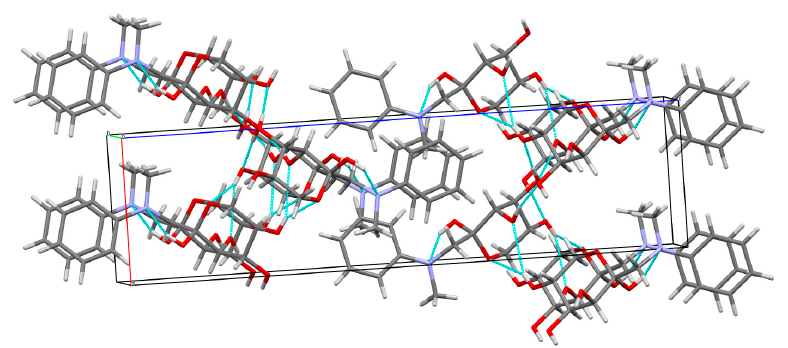
Figure 3. Crystal packing of N -(1-deoxy- α - D -tagatopyranos-1-yl)- N -methylaniline. Hydrogen bonds are shown as cyan dotted lines. Color coding for the crystallographic axes: red— a , green— b , blue— c .